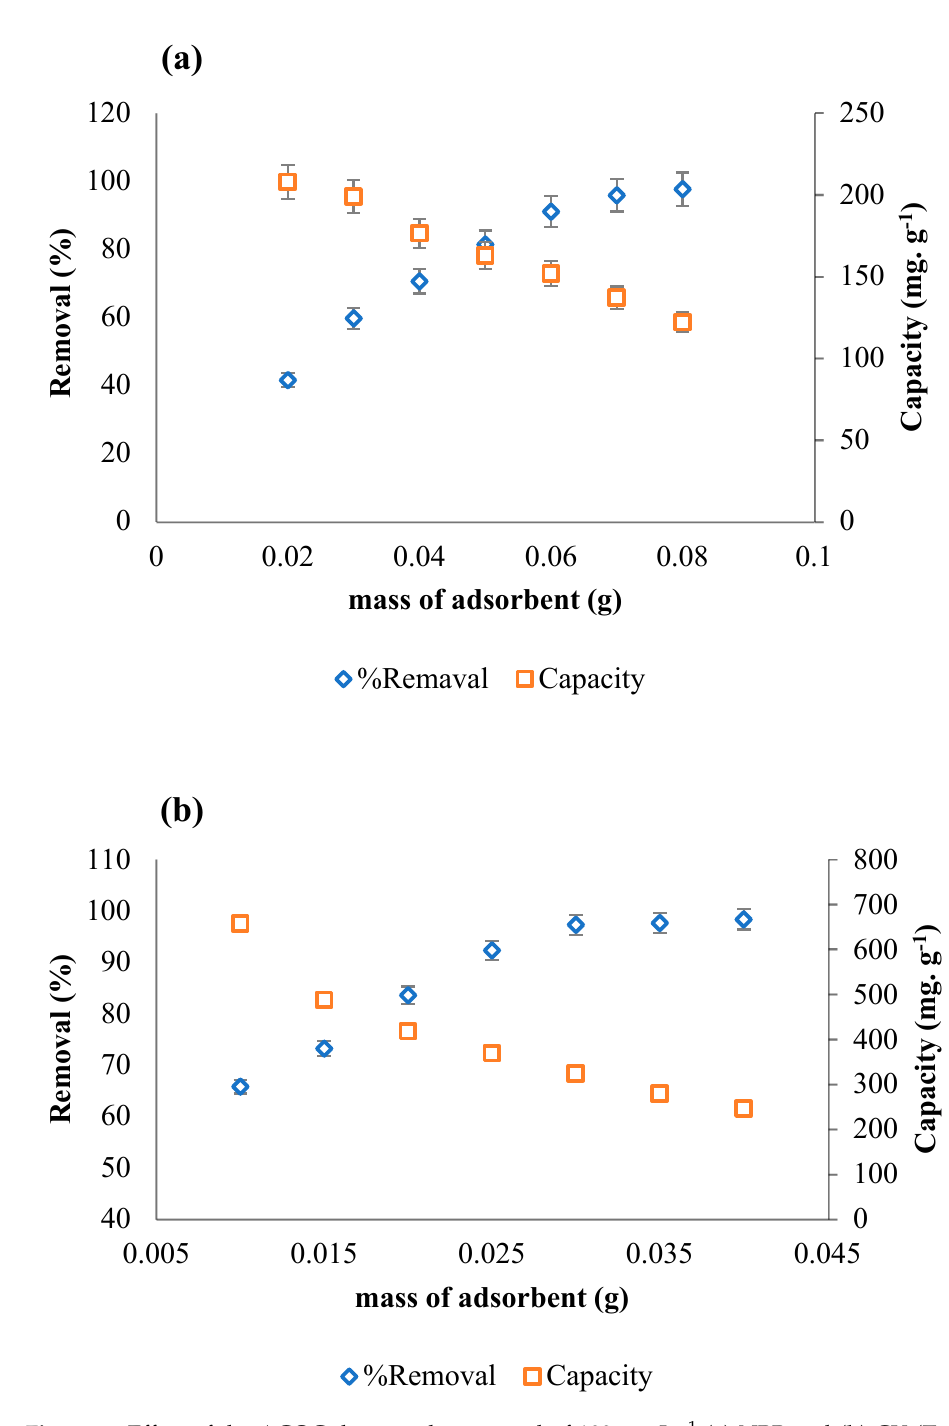
Figure 7. Effect of the ACOC dose on the removal of 100 mg L − 1 ( a ) NBB and ( b ) CV (T: 25 °C, V = 100 mL).